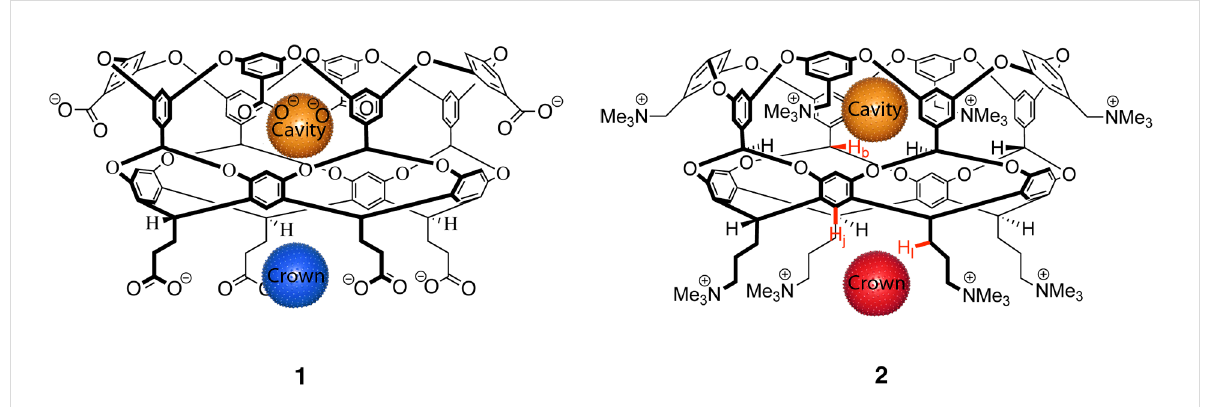
Figure 1: Chemical structures of octaacid 1 and positand 2 showing the anionic binding sites of the two hosts (orange and red) and the potential cationic binding site of 1 (blue).